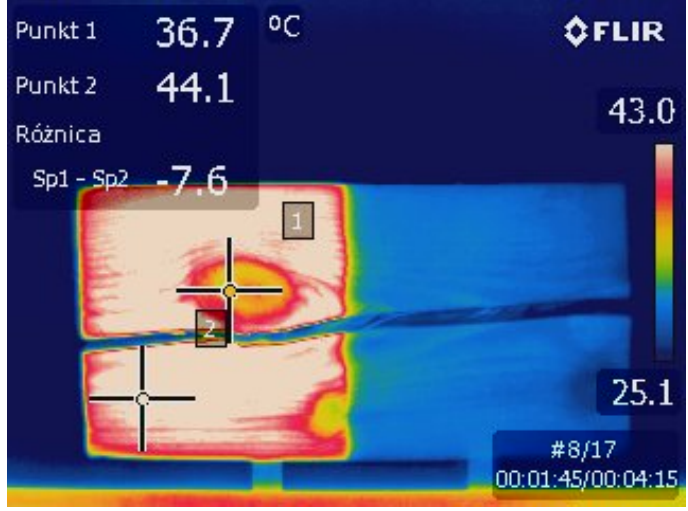
Figure 12. An example of a thermal image of a pine sample (surface A) during continuous heating with halogen lamps.